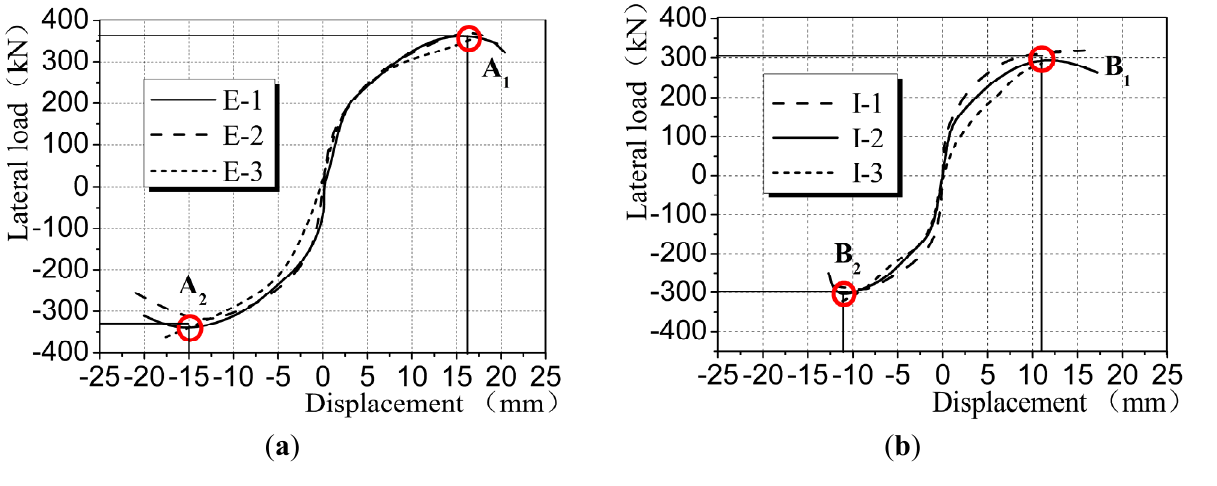
Figure 11. Skeleton curves of CEW/CIW. ( a ) CEW; ( b )